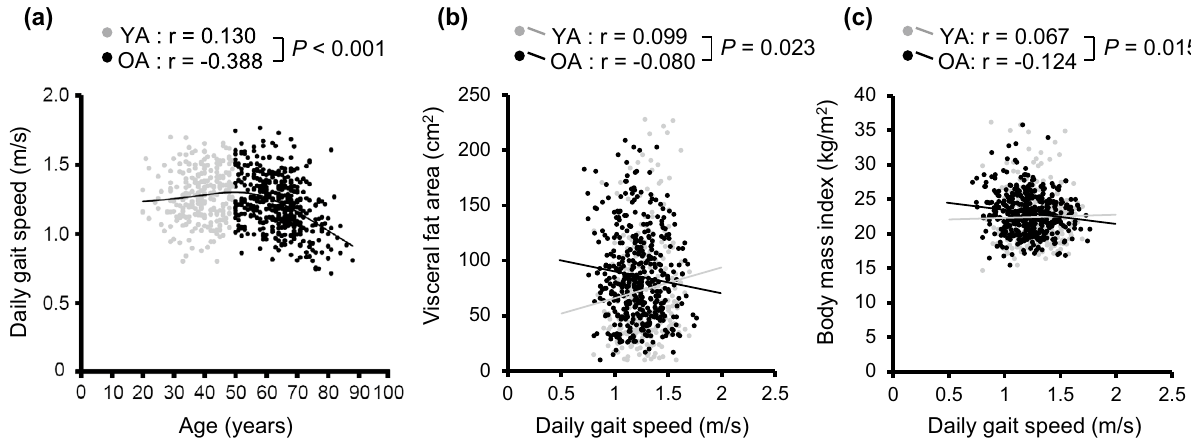
Figure 1. Association between daily gait speed (DGS) and age or visceral fat area (VFA) or body mass index (BMI). ( a ) Scatter plot with smoothing spline for the relationship between age and DGS (n = 699). The vertex was 49.8 years. ( b , c ) Scatter plots with linear regression lines for the relationship between DGS and VFA or BMI. Grey circles and lines represent younger adults (YA; age 20–49 years, n = 255) and black circles and lines represent older adults (OA; age 50–88 years, n = 444). The test for the group differences between the correlation coefficients was performed using Spearman’s correlation